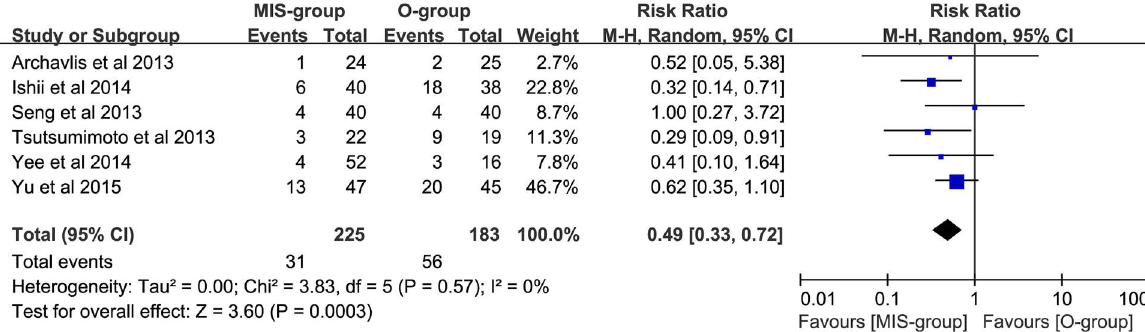
Fig 3. The comparing of ASP incident rate in single level lumbar interbody fusion between MIS and open groups.